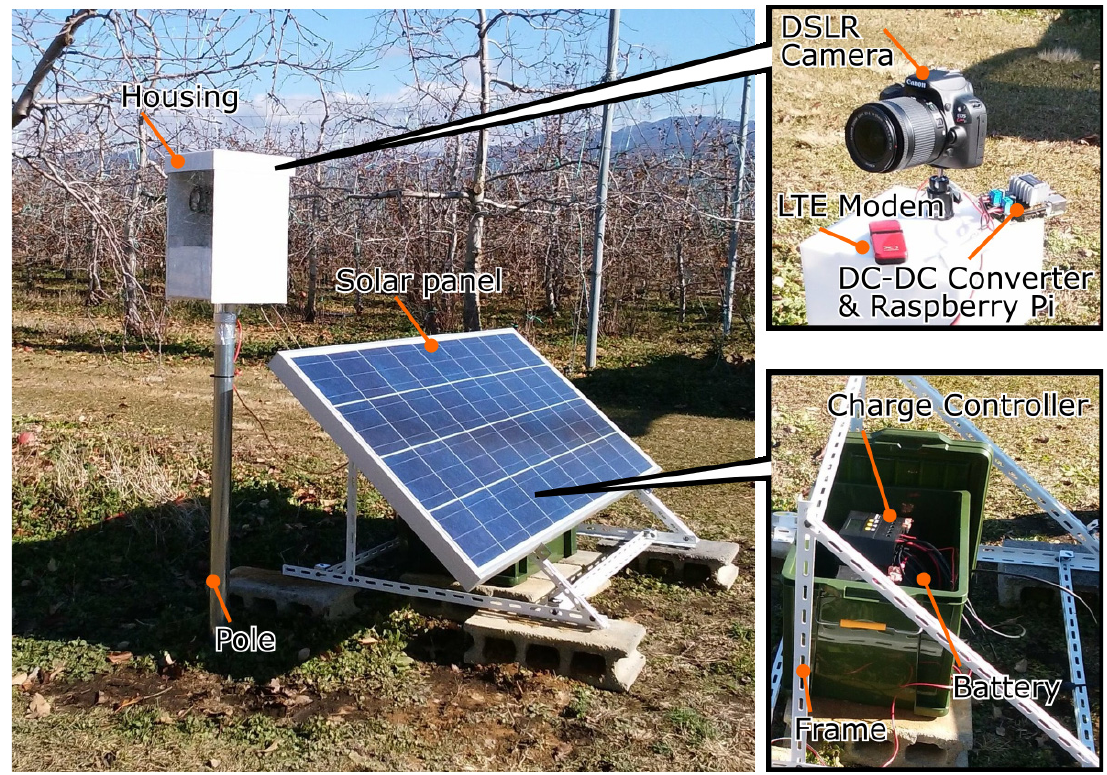
Figure 1. Monitoring device and its structure. The device sourced electric power from a solar panel and charged a 12 V battery via a charge controller. Two DC–DC converters, via a charge controller, converted electric power to 5 V and 7.4 V and supplied a Raspberry Pi 2 Model B microcontroller and DSLR camera. Images captured with the DSLR camera were temporarily stored on the micro- controller and then transmitted to a web server via a USB LTE modem.